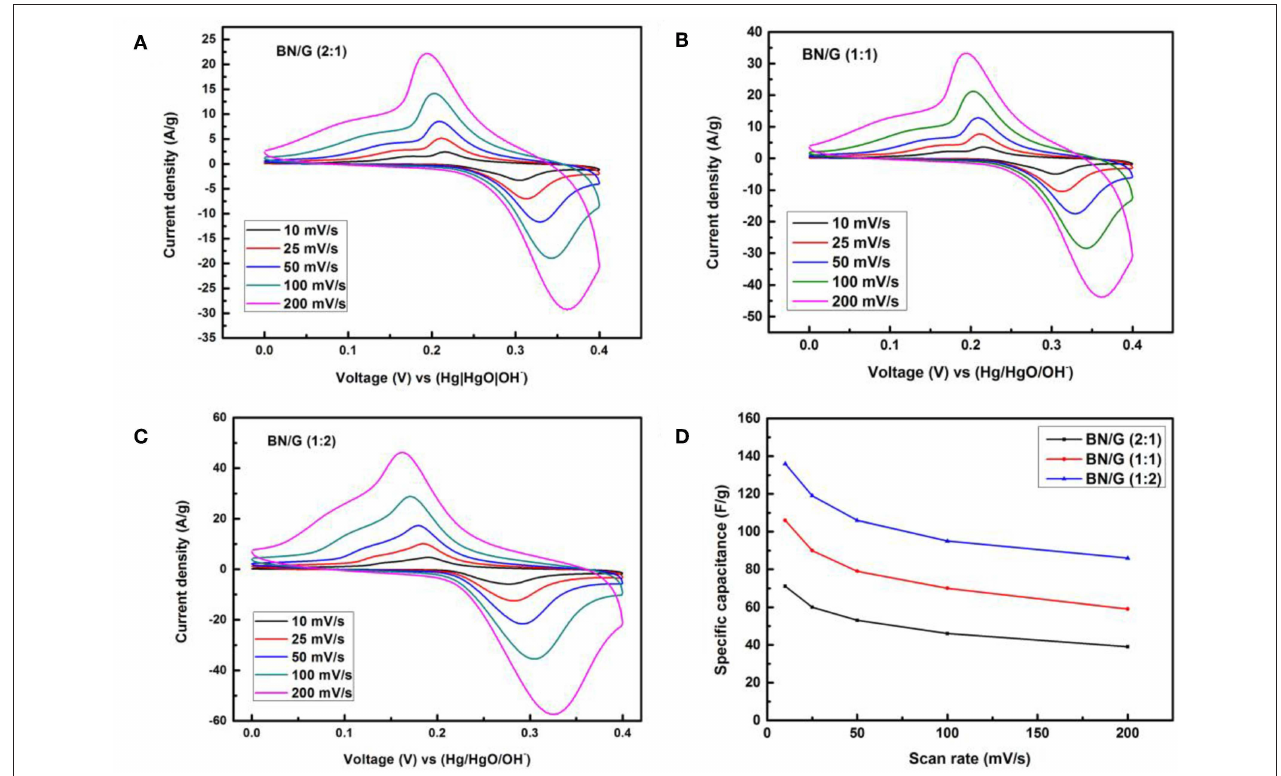
FIGURE 5 | CVs of all BN/G at different scan rates (A–C) and (D) tendency of the specific capacitance of three BN/G samples at scan rates of 10–200 mV/s.